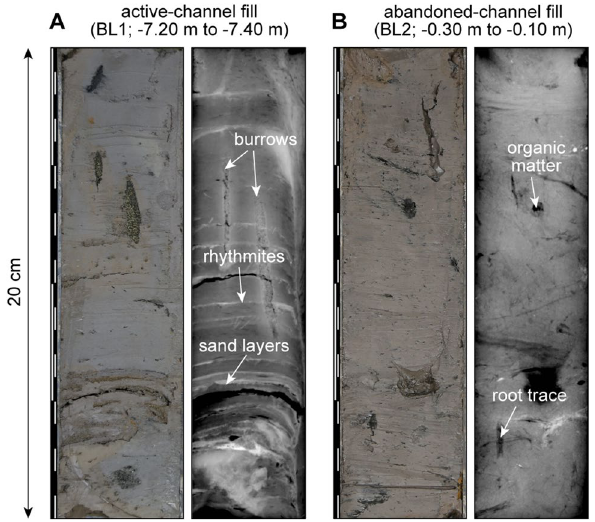
Figure 5. Selected photographs and x-radiographs showing a 20-cm-long part of the cores and highlighting the difference in sedimentary facies between the ( A ) active-channel fill and ( B ) abandoned-channel